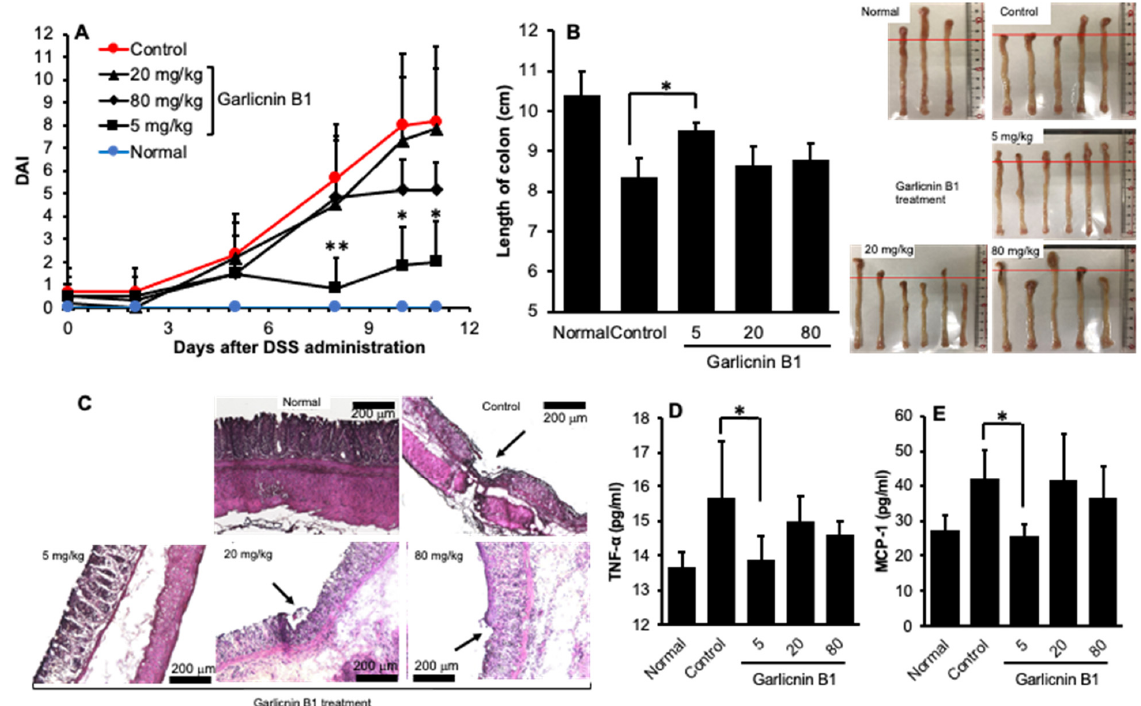
Figure 3. The therapeutic effect of garlicnin B1 on dextran sulfate sodium (DSS)-induced murine colitis was evaluated. The DSS-induced colitis model was established by oral administration of 2% DSS. During the experiment, colitis symptoms were recorded daily to obtain the disease activity index (DAI) values ( A ). Garlicnin B1 treatment was initiated thrice a week from the 1st day of DSS administration. On day 11, when severe colitis appeared, the mice were sacrificed, the length of the colon was measured ( B ), and a histological examination of the colon was performed ( C ). Plasma levels of inflammatory cytokines (TNF- α and MCP-1) were also measured ( D , E ). The arrows indicate tissue damage in the colon mucosa. Values are presented as means ± standard deviation (SD); n = 6. * p < 0.05, ** p < 0.01. Bar, 200 µm. See text for details.